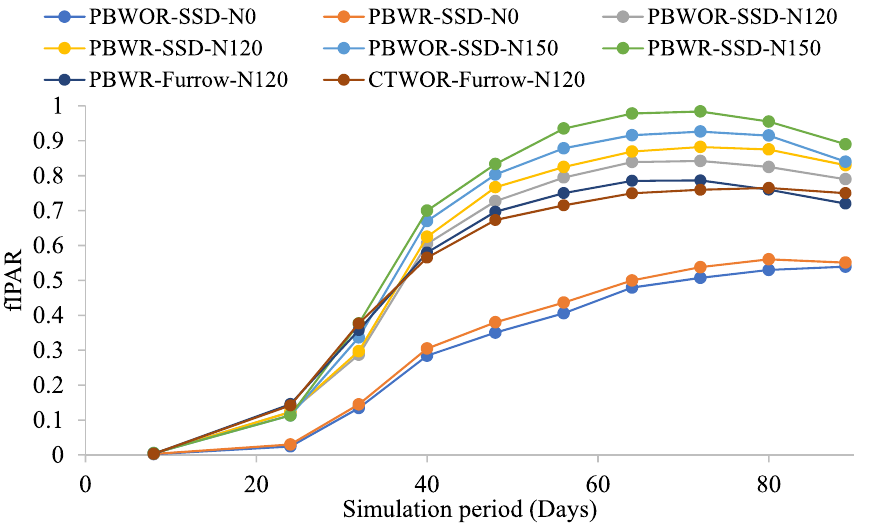
Figure 1. Effect of different tillage, residue, N and irrigation management treatments on fIPAR of maize. fIPAR: Fractional Intercepted Photosynthetically Active